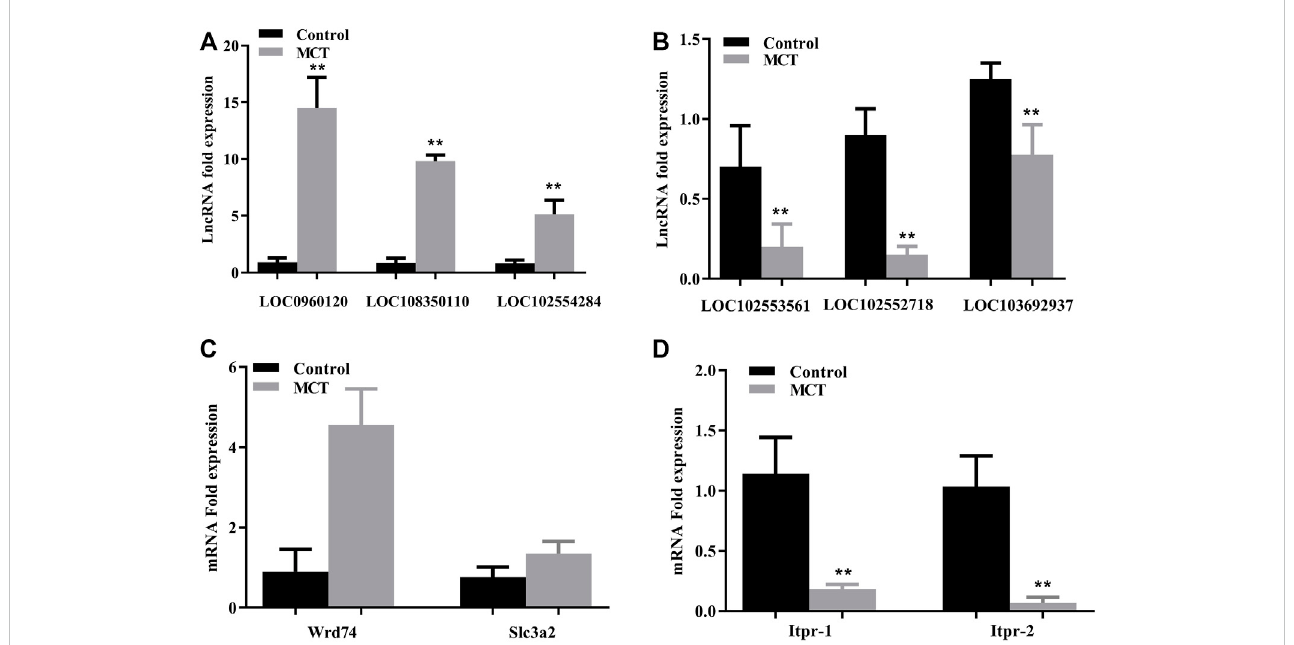
FIGURE 4 Validation of microarray results using RT-PCR. (A) Relative expression of upregulated lncRNAs LOC0960120, LOC108350110, and LOC102554284. (B) Relative expression of downregulated lncRNAs LOC192553561, LOC102552718, and LOC103692937. (C) Relative expression of upregulated mRNAs (Wrd74 and Slc3a2). (D) Relative expression of downregulated mRNAs (Itpr1 and Itpr2). Itpr1 : inositol 1,4,5-trisphosphate receptor type 1; Wdr74: WD repeat domain74; Slc3a2: solutecarrierfamilythreemember2.Dataarepresentedintheformmean±SD. n =6ratspertimepoint. *p ≤ 0.05;** p ≤ 0.01;*** p ≤ 0.001 in comparisons of the MCT-treated group against the control